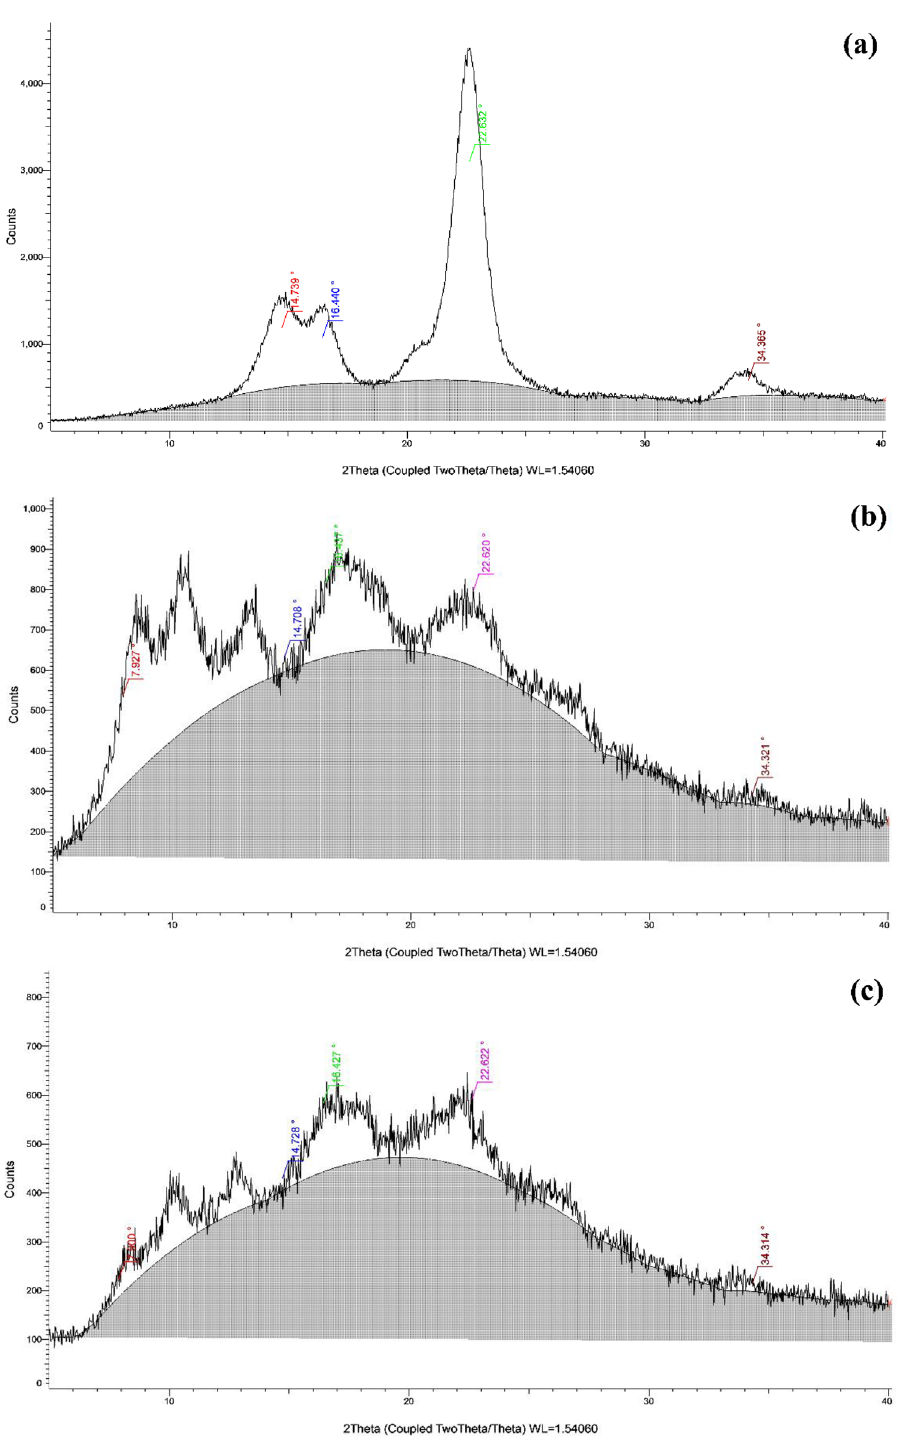
Figure 8. XRD analysis of ( a ) Cellulose extracted from cotton Giza 86, ( b ) Cellulose di-acetate, (c) CA-PEG blend